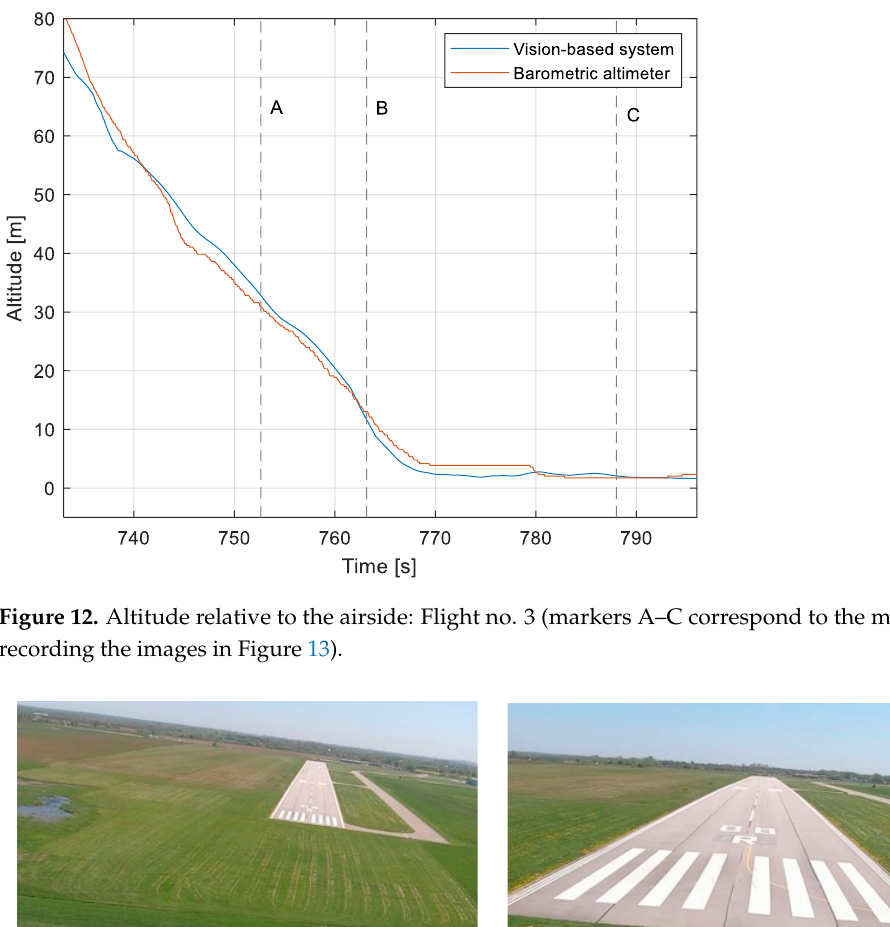
Figure 13. Recorded images related to the altitude measurements presented in Figure 12.